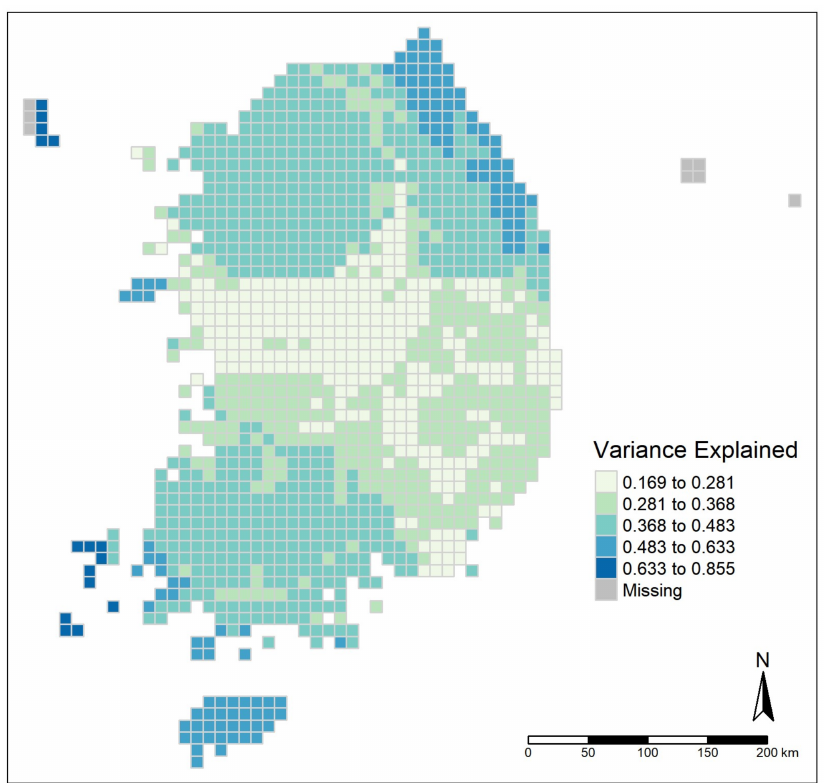
Figure 7. Variance explained by the first three sparse components constructed for 1346 local subsets.